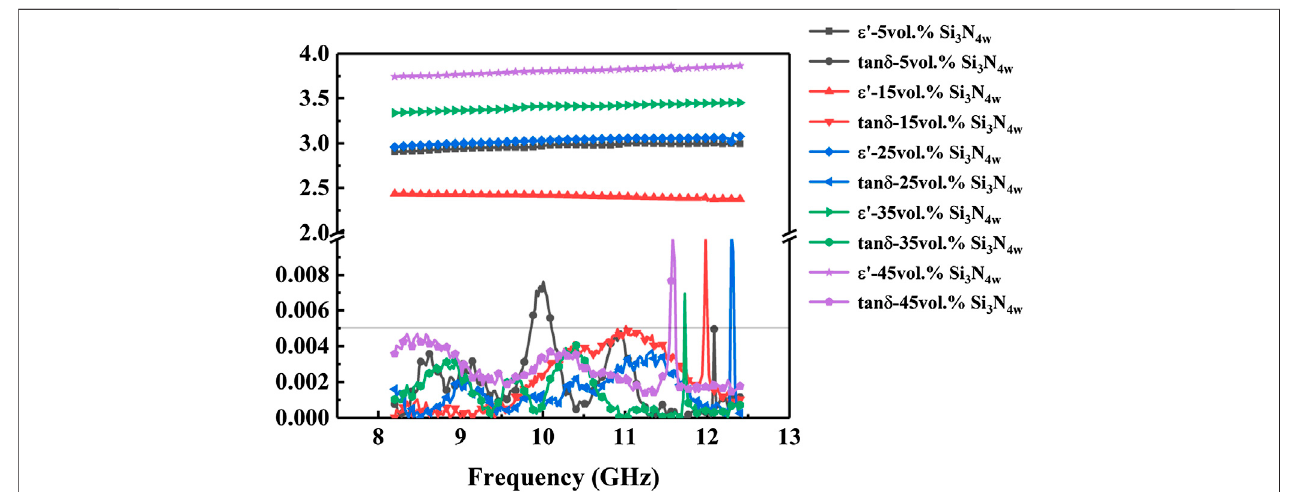
FIGURE 13 | Dielectric properties of the fi ve kinds of Si 3 N 4w /Si 3 N 4 .